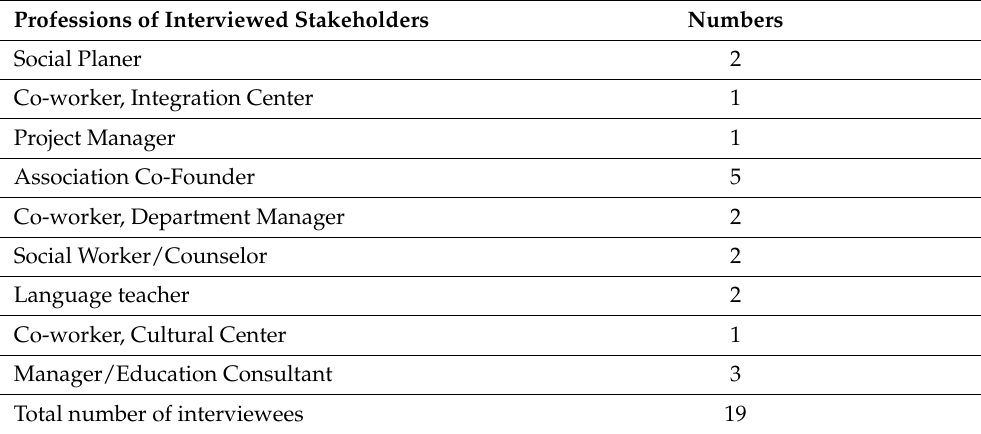
Table 1. Professional titles of